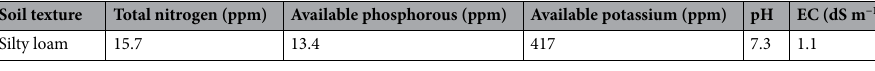
Table 1. Soil properties of the experimental field.